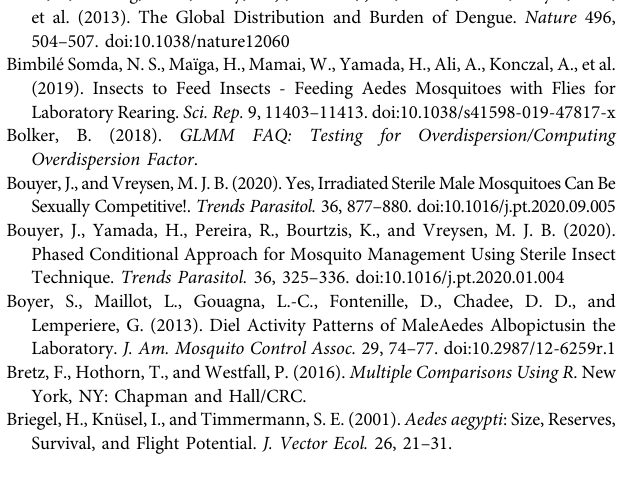
Supplementary Figure S1 | Mean wing lengths of Aedes albopictus strains from different origins. Strains originated from Rimini, Italy; Valencia, Spain; and Guangzhou, China. Black bars indicate the median; the upper and lower limits of each box indicate the interquartile range. Each dot represents a value of measured wing